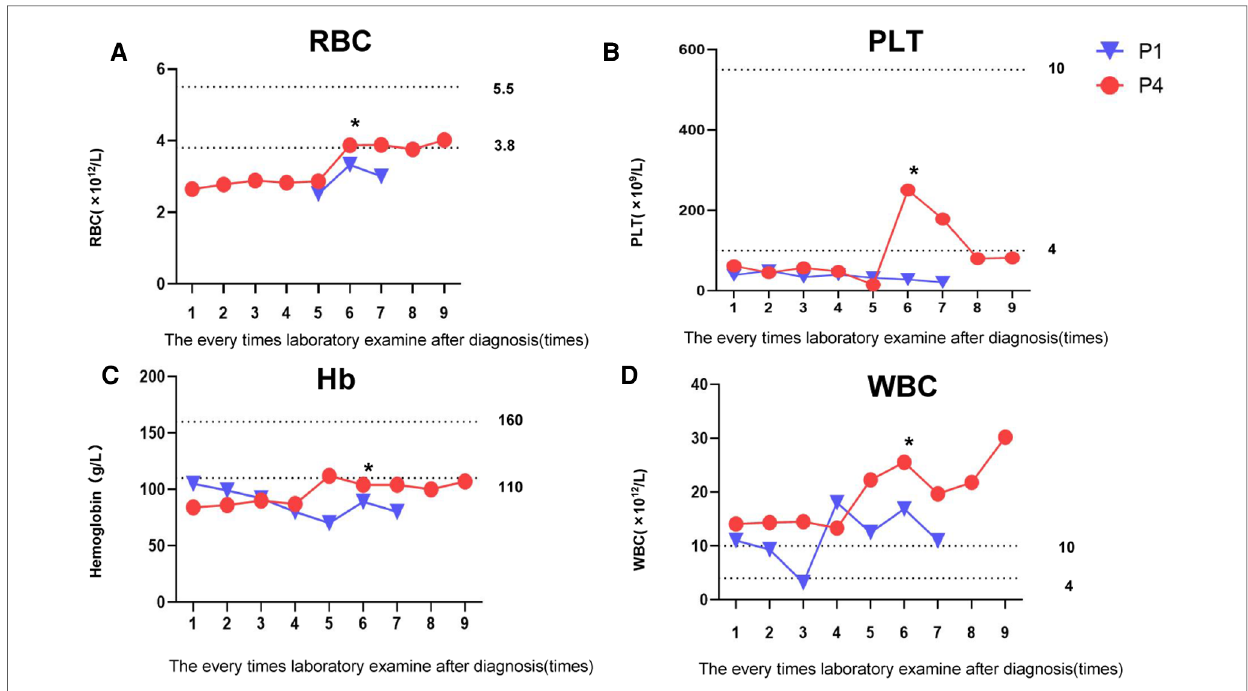
FIGURE 1 Changes in patients ’ routine blood examination. ( A ) Changes in patients ’ RBC levels. ( B ) Changes in patients ’ PLT levels. ( C ) Changes in patients ’ Hb levels. ( D ) Changes in patients ’ WBC levels. *Transfusion treatments: Patient 1 received RBC 0.25 U; Patient 4 received PLT 0.75